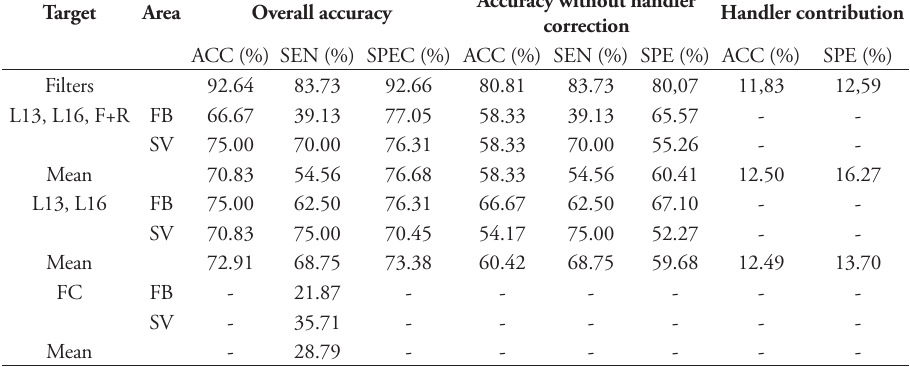
TOT Table 8. Summary of Teseo’s accuracy (ACC), sensitivity (SEN) and specificity (SPEC). Filters: the filters with odour of the larvae of O.eremita ; L13, L16: larvae recorded in 2013 and 2016; F+R: frass and remains of adults; FC: larvae of flower chafers; FB: Forcella Buana; SV: San Vito.